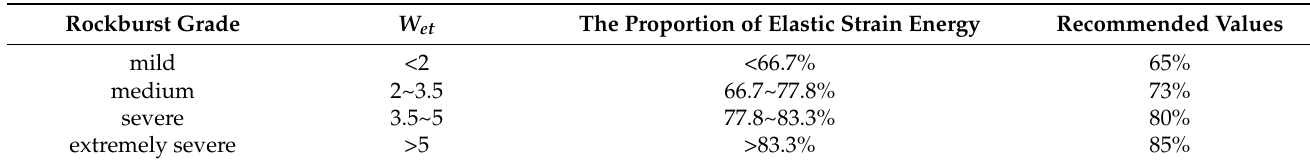
Table 1. The proportion of elastic strain energy of surrounding rock under different grades of rockburst.